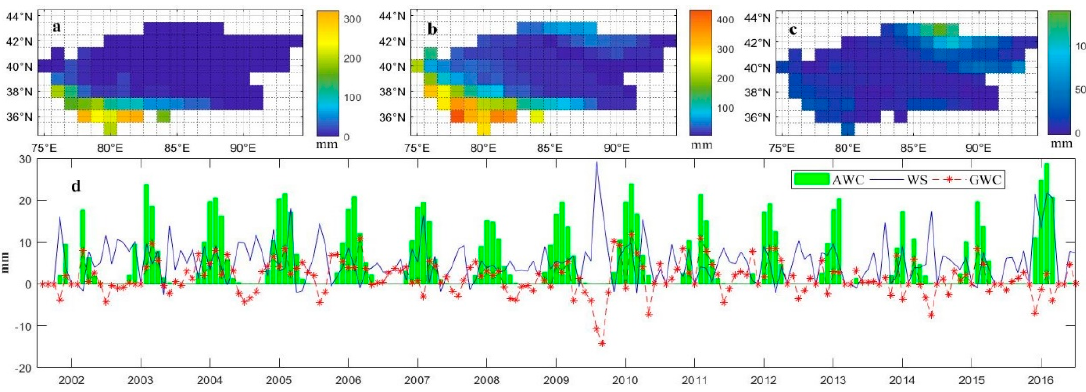
Figure 4. The annual average spatial distribution of agricultural water consumption (AWC), water supply (WS), and groundwater change (GWC) during 2002–2016. (( a – c ) are spatial distributions of the annual AWC, WS, and GWC, respectively; ( d ) is the monthly average change trends of AWC, WS, and GWC at the 1° × 1° grid over the region).